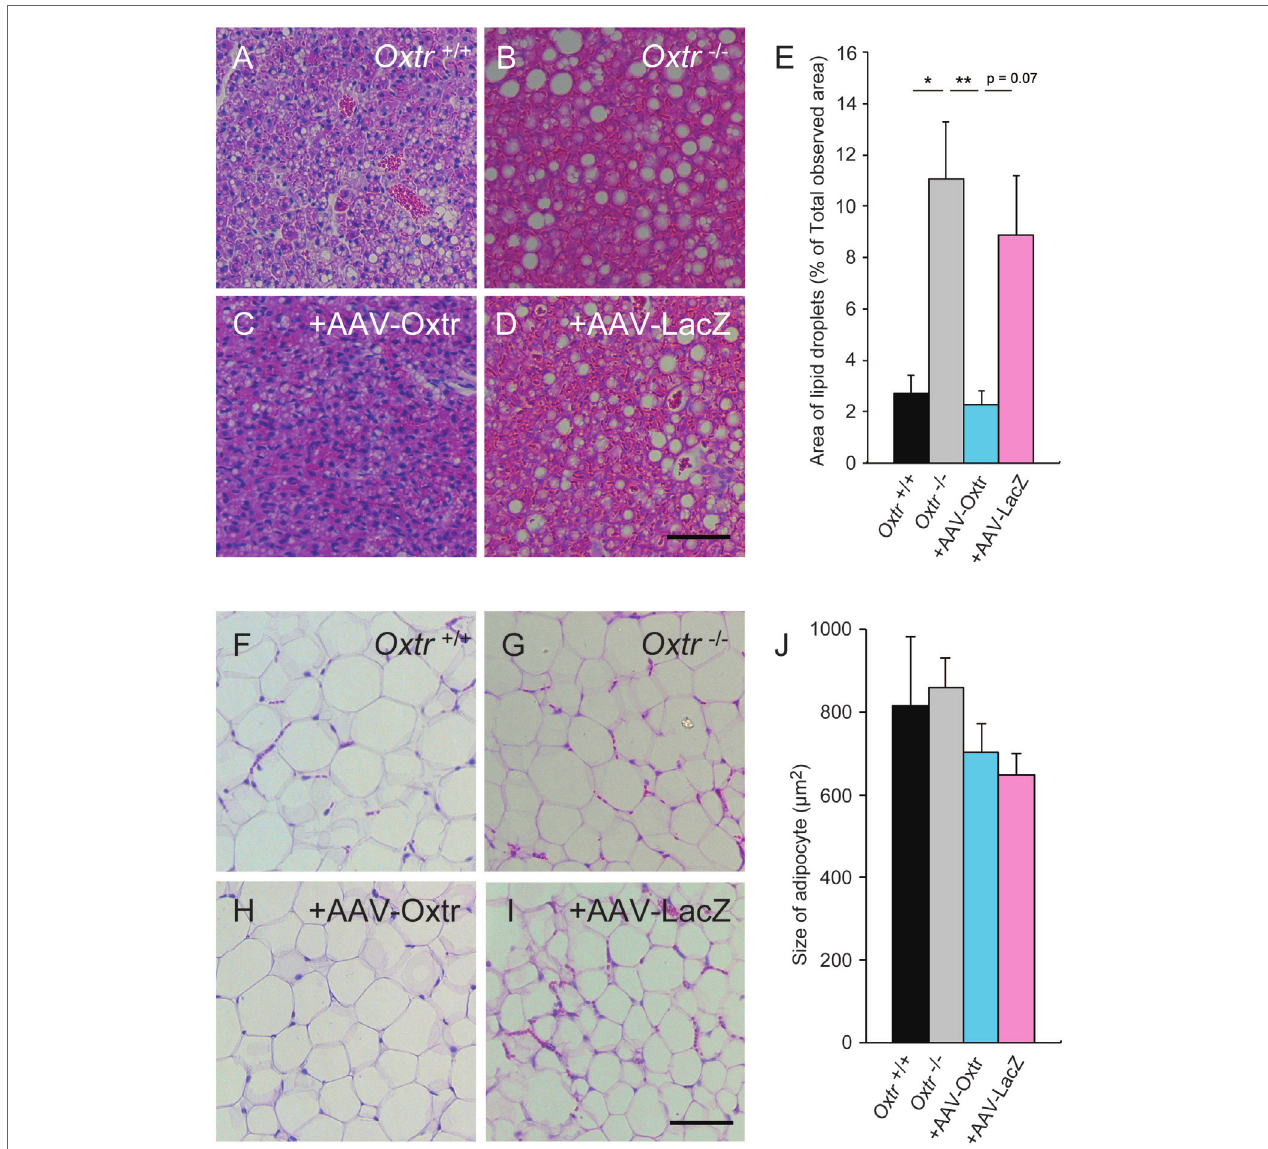
FigUre 3 | excessive lipid accumulation in the BaT of Oxtr − / − mice was recovered by in aaV-Oxtr injection . Hematoxylin and eosin stained brown (a–D) and white (F–i) adipose tissues from Oxtr + / + mice (a,F) , Oxtr − / − mice (B,g) , Oxtr -/ − mice with AAV-Oxtr injection into RMR (c,h) and Oxtr − / − mice with AAV-LacZ injection into RMR (D,i) . (e) Areas of lipid droplets in BAT of Oxtr + / + ( n = 5), Oxtr − / − ( n = 7), + AAV-Oxtr ( n = 6) and + AAV-LacZ ( n = 6) mice. (J) Size of adipocytes in WAT of Oxtr + / + ( n = 4), Oxtr − / ( n = 5), + AAV-Oxtr ( n = 5), and + AAV-LacZ ( n = 6) mice. *; p < 0.05, ** p < 0.01, significant differences between groups. Scale bar: 60 μ